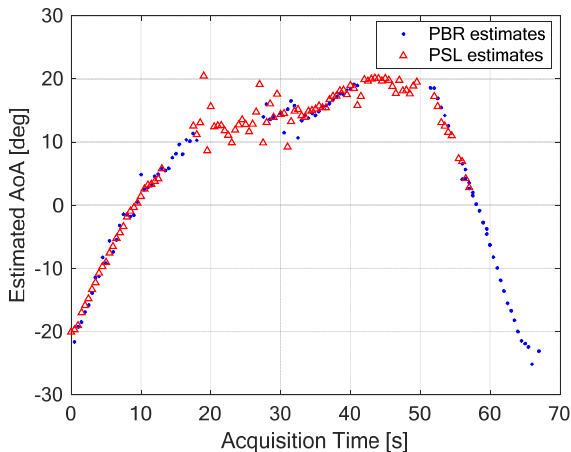
Figure 11. Comparison between the AoA estimations with the PBR technique and PSL technique.